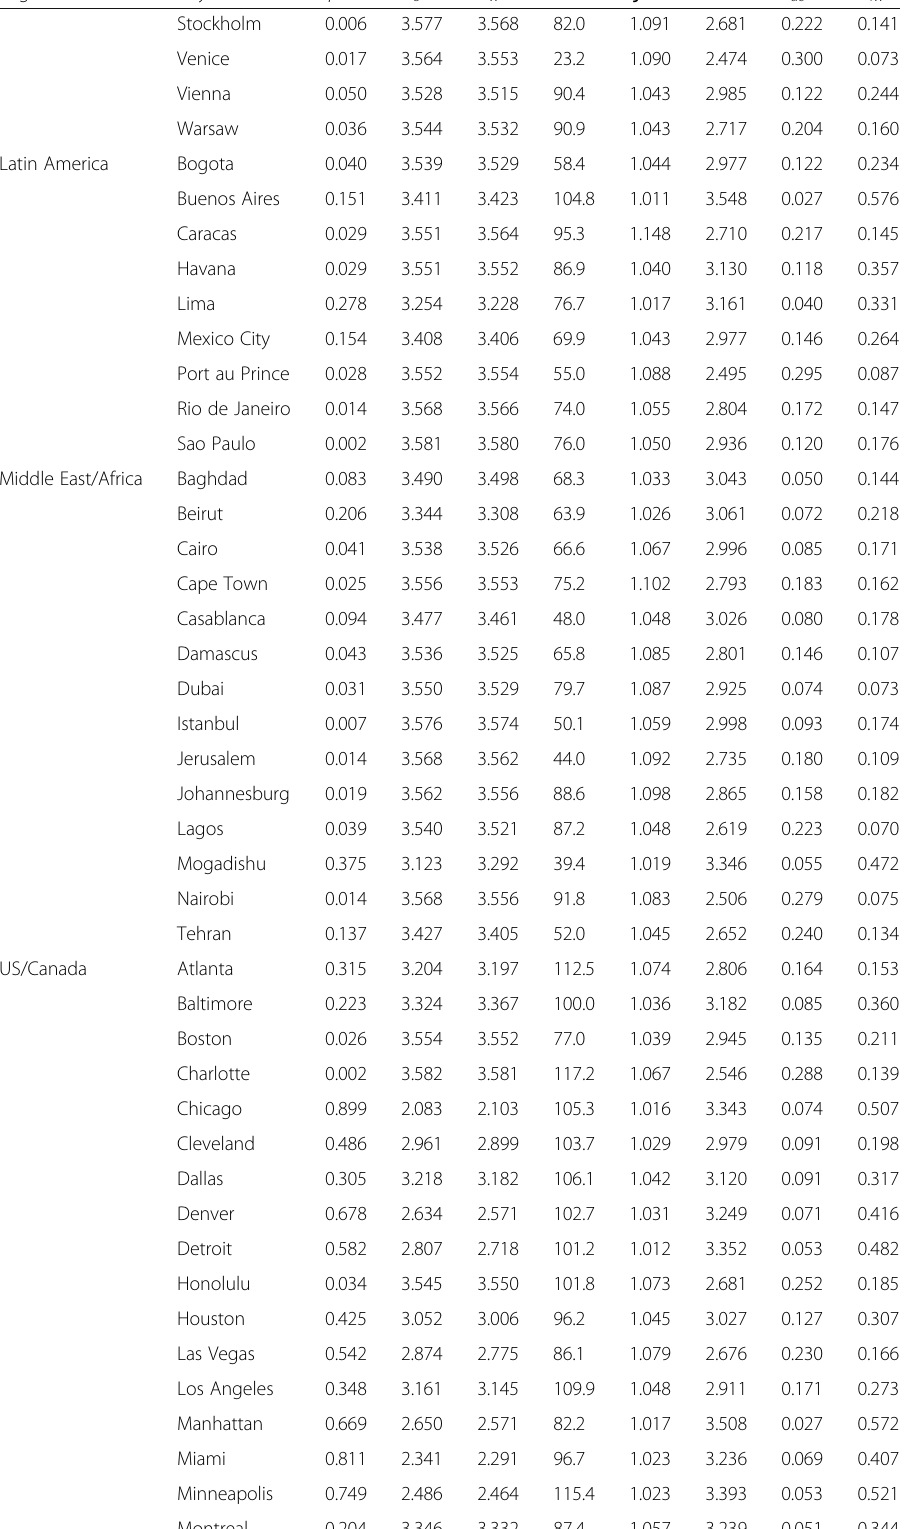
Table 1 Resulting indicators for the 100 study sites (Continued) Region